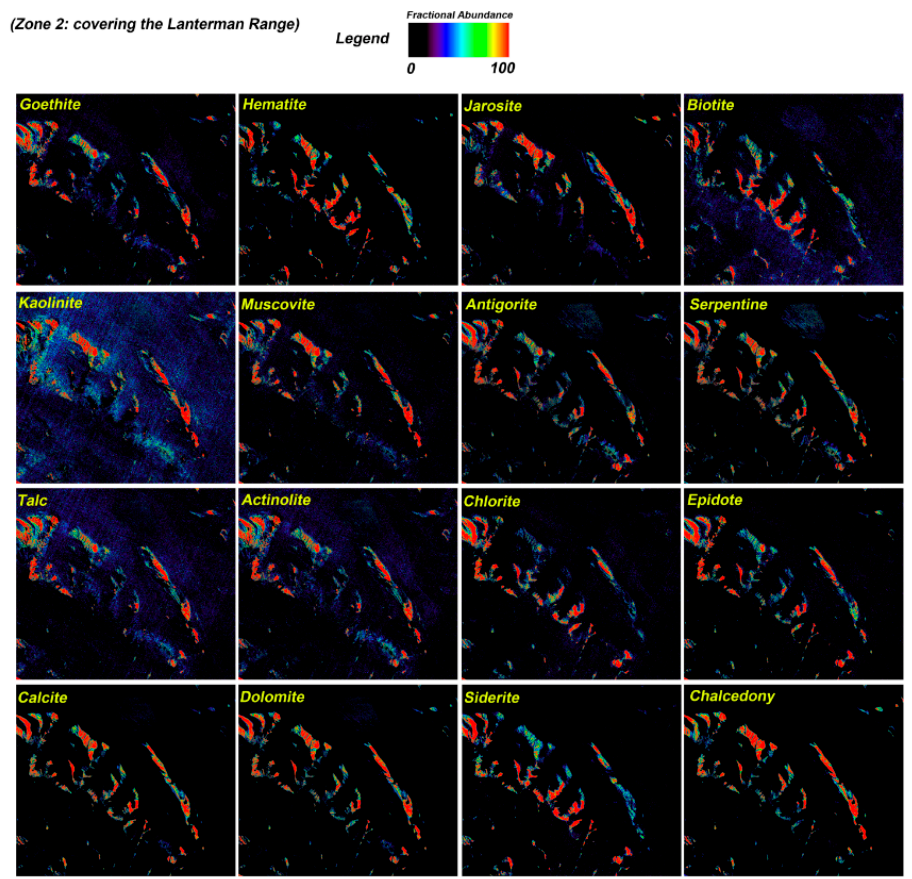
Figure 11. Fraction images of the selected end-member minerals derived from CEM algorithm for zone (2) covering the Lanterman Range and surrounding areas. Pseudo-color ramp was applied to greyscale rule images.